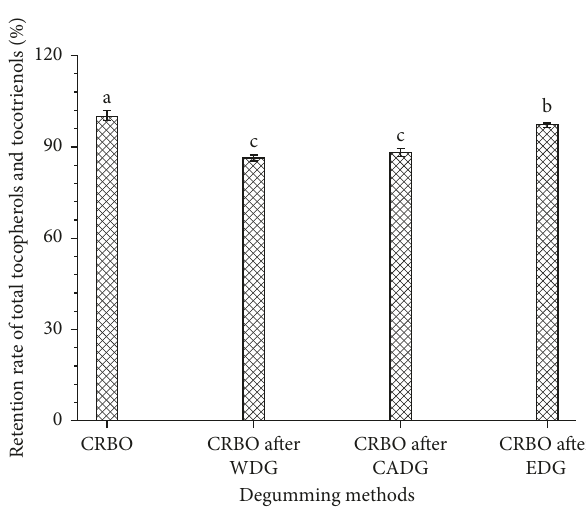
Figure 4: Effect of degumming methods on retention rate of total 0 . 05). tocopherols and tocotrienols. Note: lowercase superscripts repre- sent significant differences between different methods ( P <